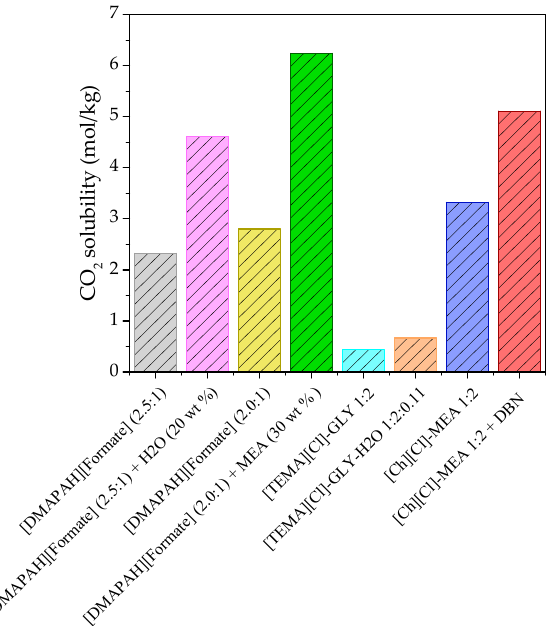
Figure 4. Comparison of CO 2 solubility for IL and IL-based hybrid solvent, as well as DES and DES-based hybrid solvent.